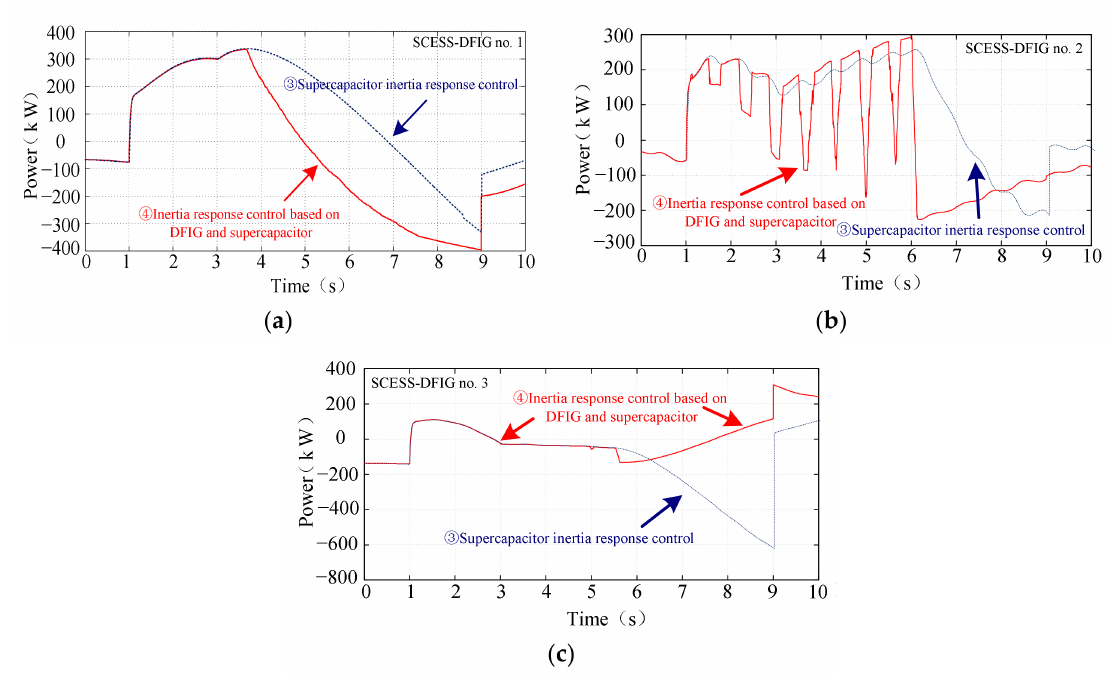
Figure 19. Comparison of output power of the single GSC under different control strategies: ( a ) The GSC output power under different control strategies for no. 1 SCESS -DFIG; ( b ) The GSC output power under different control strategies for no. 1 SCESS-DFIG; and ( c ) The GSC output power under different control strategies for no. 1 SCESS-DFIG.